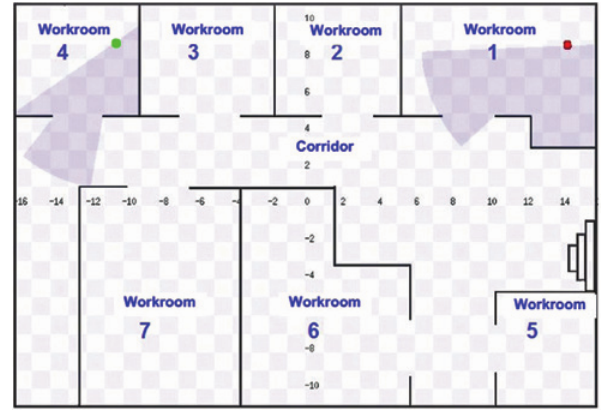
Figure 6: Ground Floor of the DPR of the CDTA Research